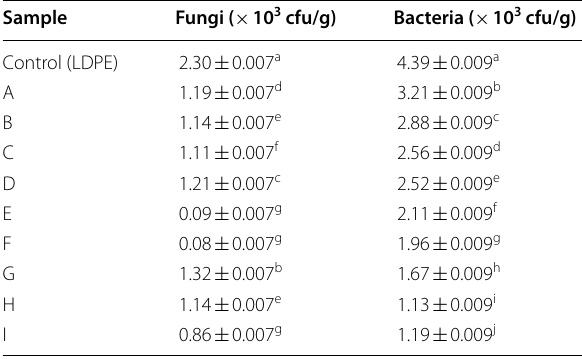
Sample A to I retain their usual properties Samples with the same letter number (a–j) are not significant at p <